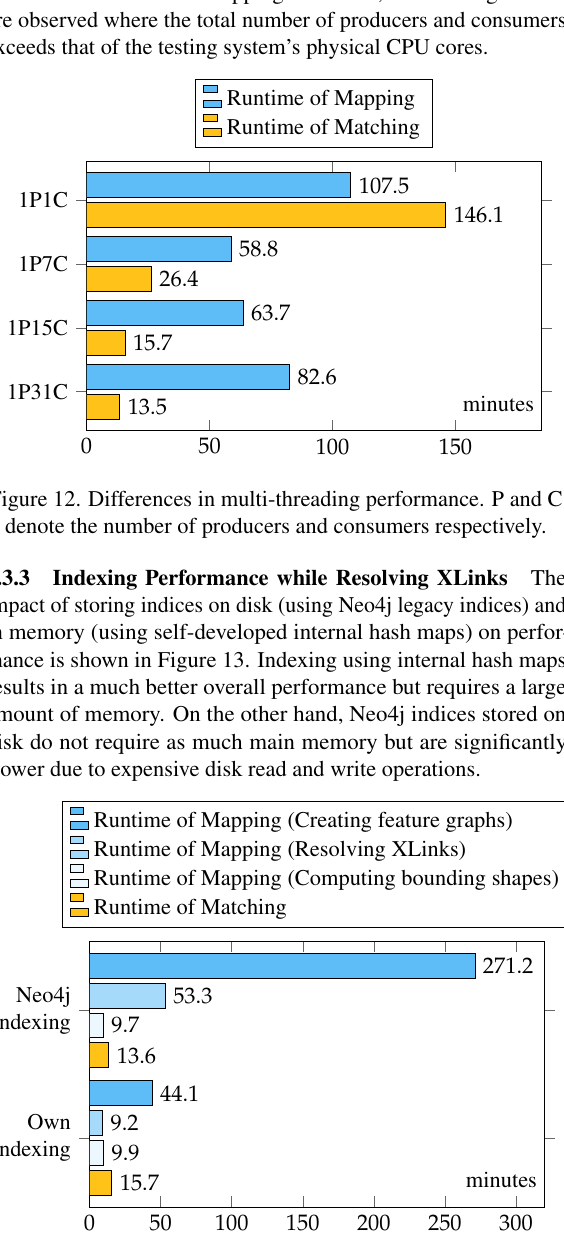
Figure 13. The performance of storing indices on disk (using Neo4j built-in indices) and in memory (using internal hash